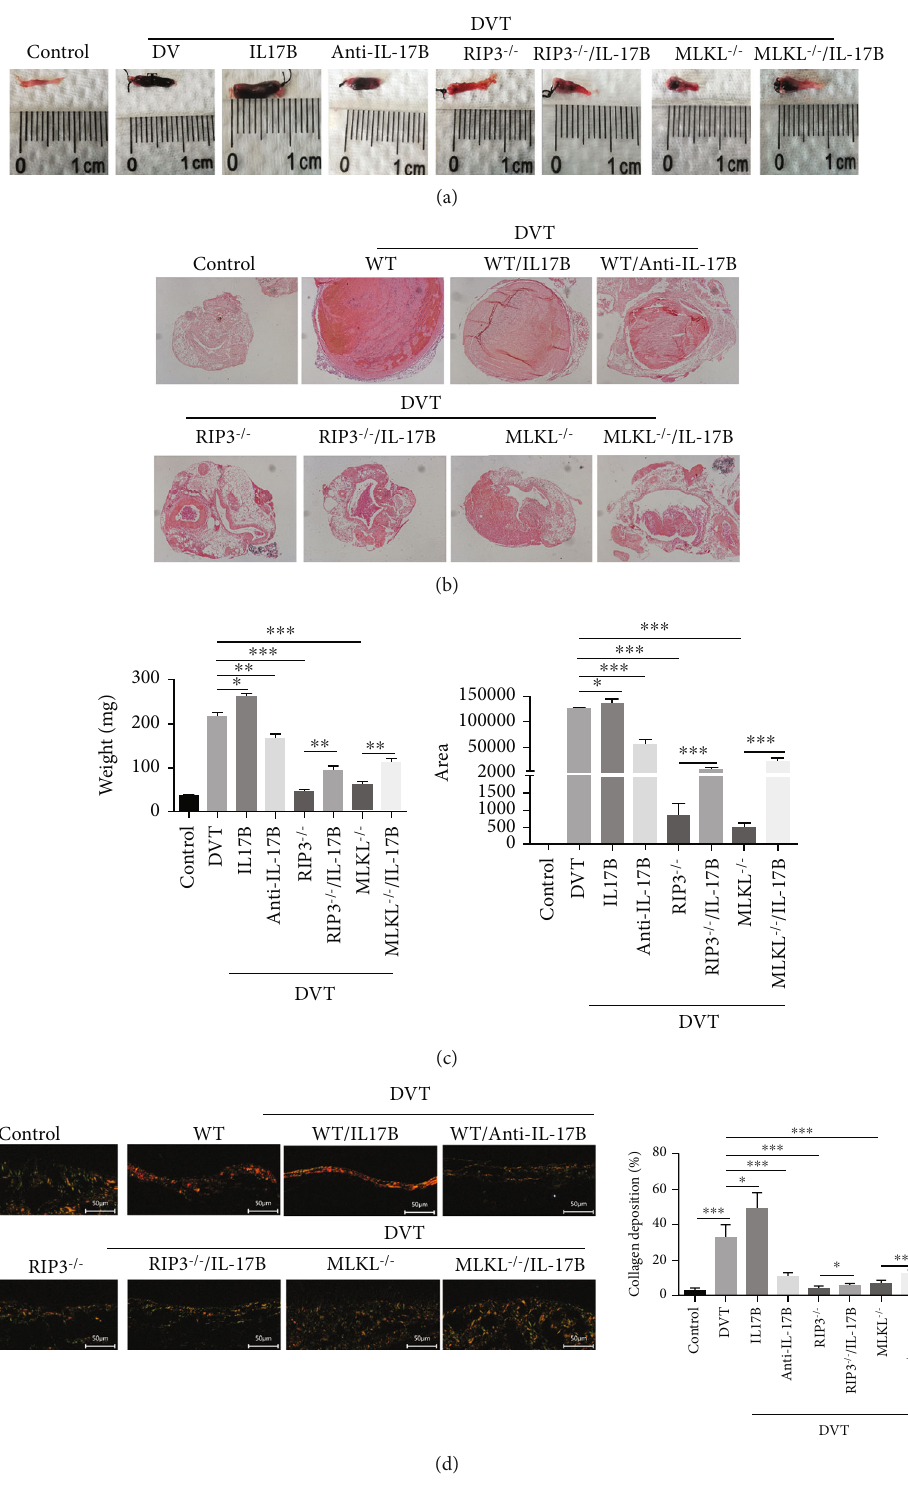
Figure 7: Necroptosis of the vessel wall facilitated by IL-17B aggravates thrombosis. (a) Gross specimens of IVC tissues (containing the thrombus) of each group were obtained from the ligation site to the bifurcation of the iliac vein and drained on absorbent paper. (b) HE staining of the thrombus in each group under a 40x light microscope. (c) The weight of the thrombi was measured by electronic balance. The cross-sectional thrombus area was measured on HE images using Image-Pro Plus 6.0. (d) Sirius red staining was done on the vein wall injury conditions. Observation with lab.A1 microscope (200x), and red represents the collagen, green represents the nucleus, and the rest is yellow. Five visual fi elds were randomly selected for double-blind observation. Collagen content was calculated using Image-Pro Plus 6.0 software. ANOVA was used for statistical analysis. ∗ P < 0 : 05 , ∗∗ P < 0 : 01 , and ∗∗∗ P < 0 : 001